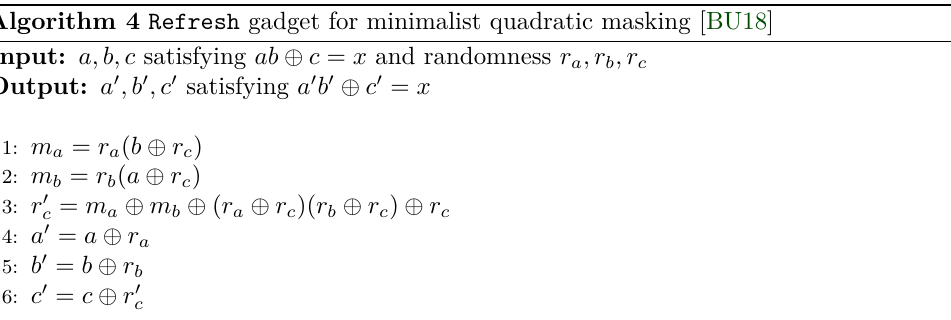
Algorithm 4 Refresh gadget for minimalist quadratic masking